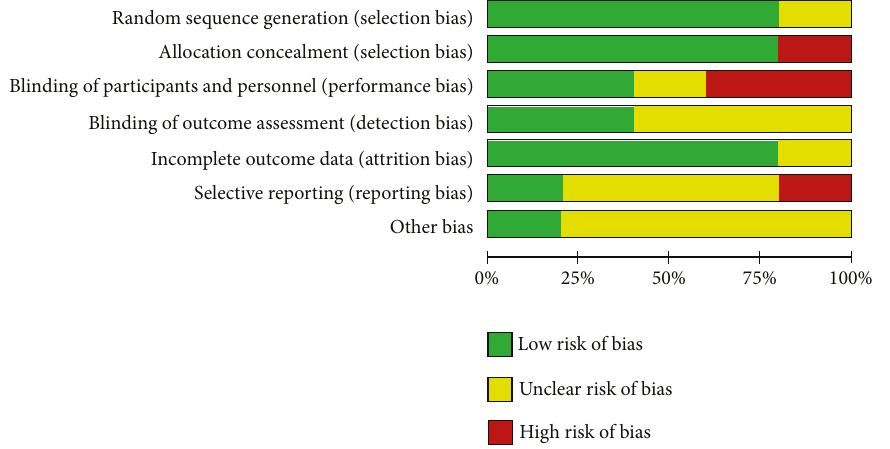
Figure 2: Risk of bias in the studies included in the systematic review.